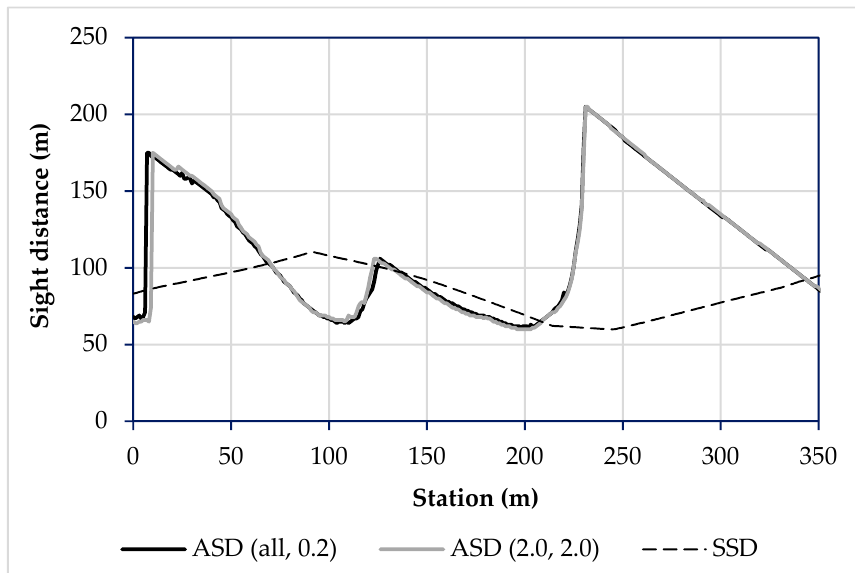
Figure 5. Comparison between ASD and required SSD in outward direction.